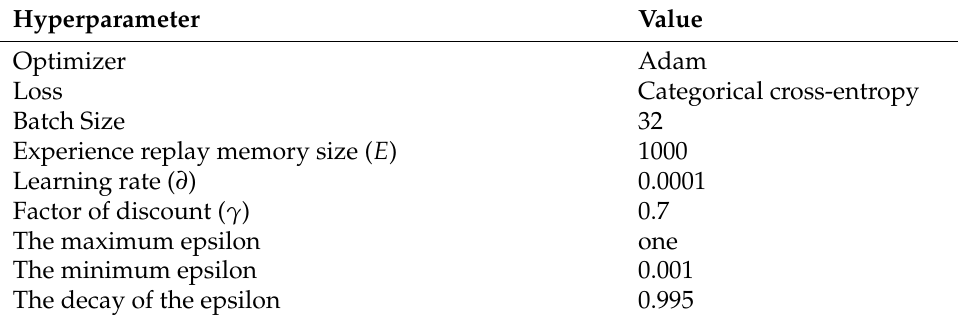
Table 2. Training